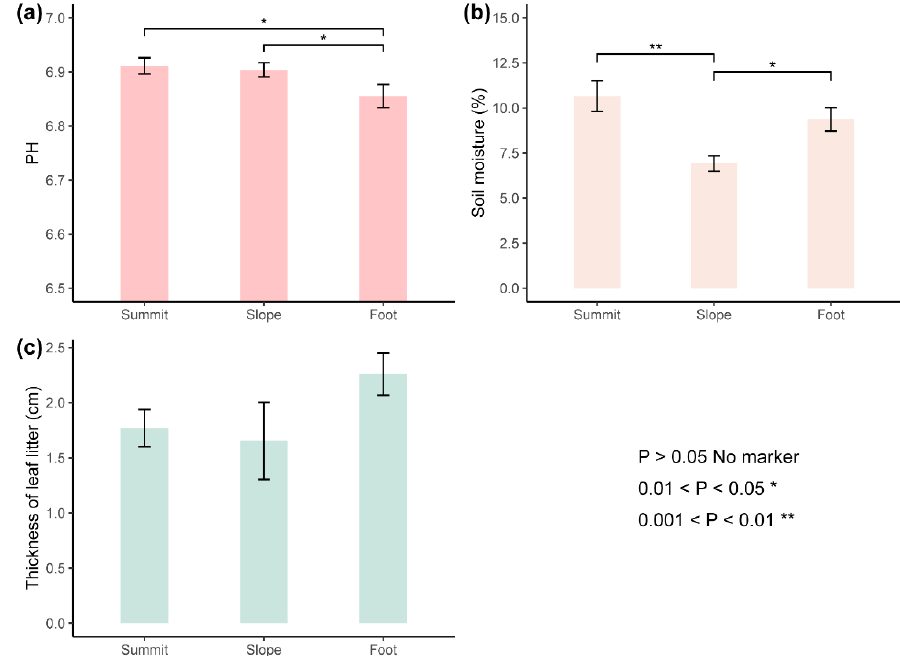
Figure 5. The environmental characteristics (mean ± SE) at three slope positions [( a ) The soil pH at the three slope positions; ( b ) The soil moisture at the three slope positions; ( c ) The thickness of leaf litter at the three slope positions].